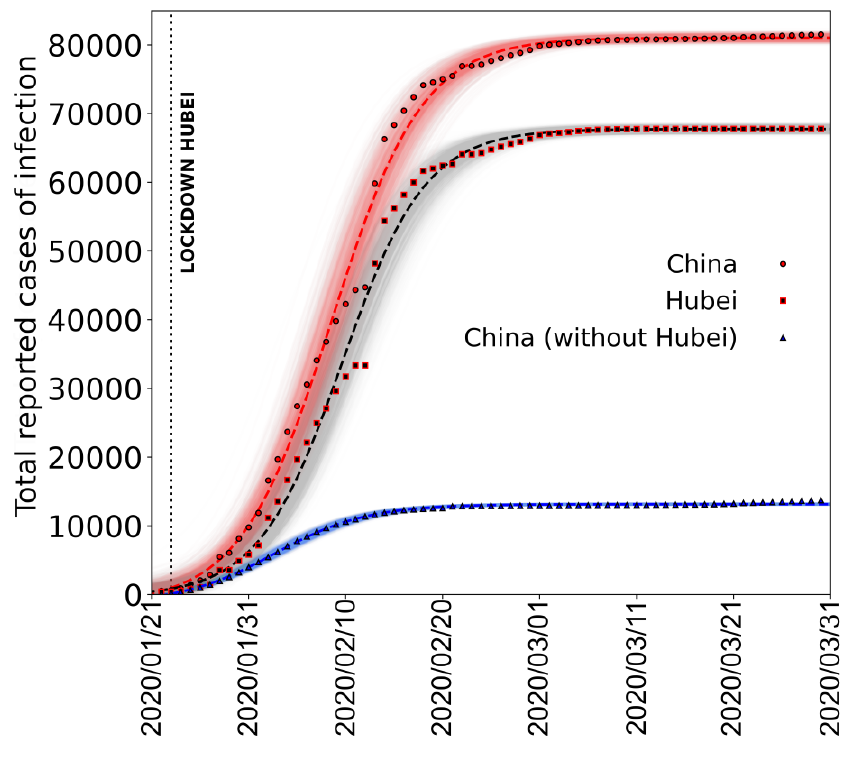
Figure 2. Total COVID-19 cases reported in China from 22 January to 31 March 2020 according to the Johns Hopkins University data repository. Circles, squares, and triangles represent total COVID-19 cases registered in China, the region of Hubei, and China without Hubei; red, black, and blue dashed lines are the associated logistic fits. Shaded areas represent the family of curves obtainable by making the fit parameters vary within their confidence intervals. Fit parameters: Logistic (𝑦 =